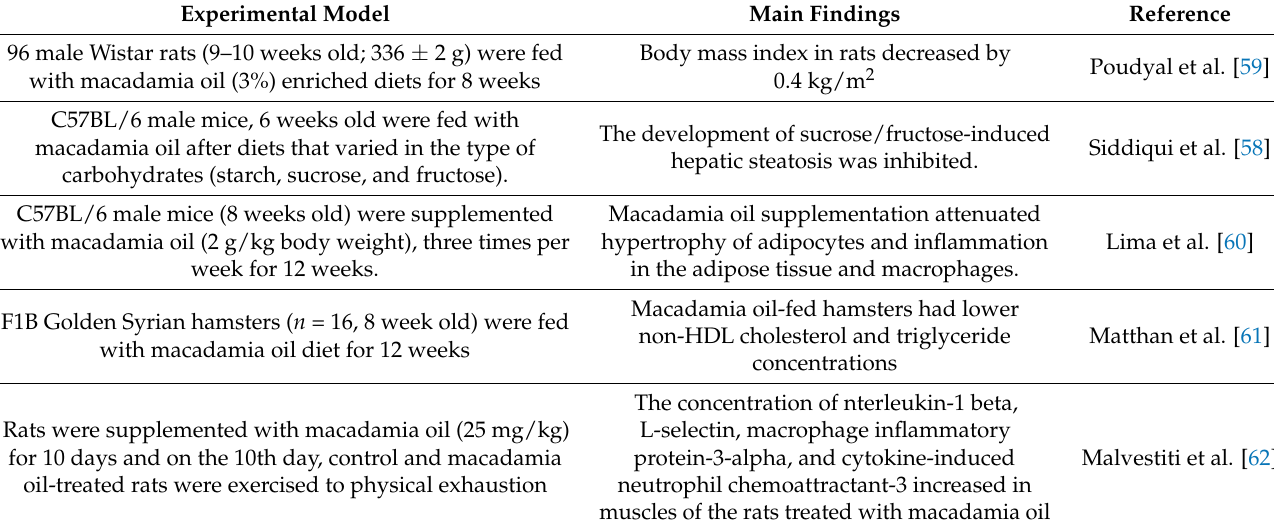
Table 5. Health benefits of commercial macadamia nut oil (in vivo studies with animal